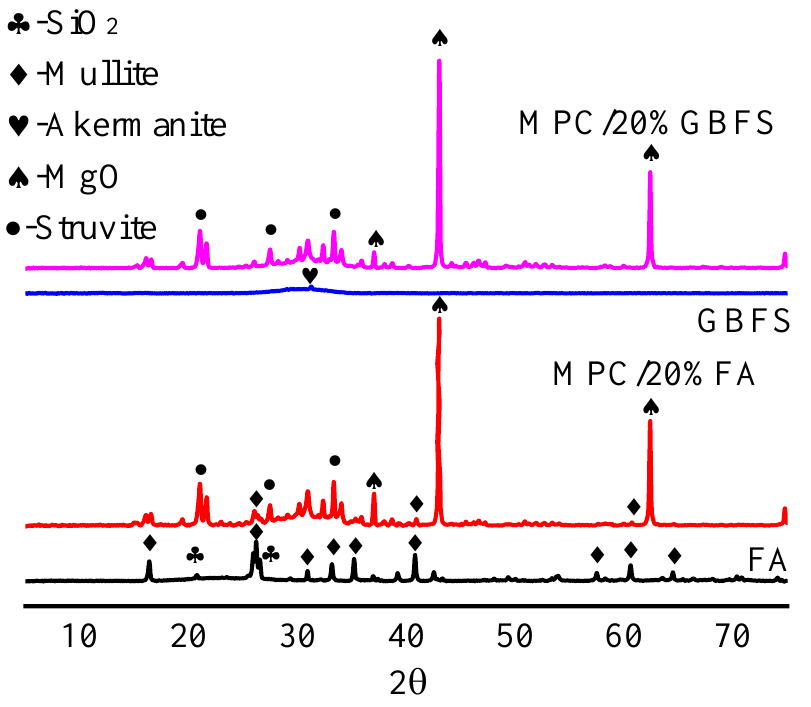
Figure 5. Component analysis of different mineral admixtures.